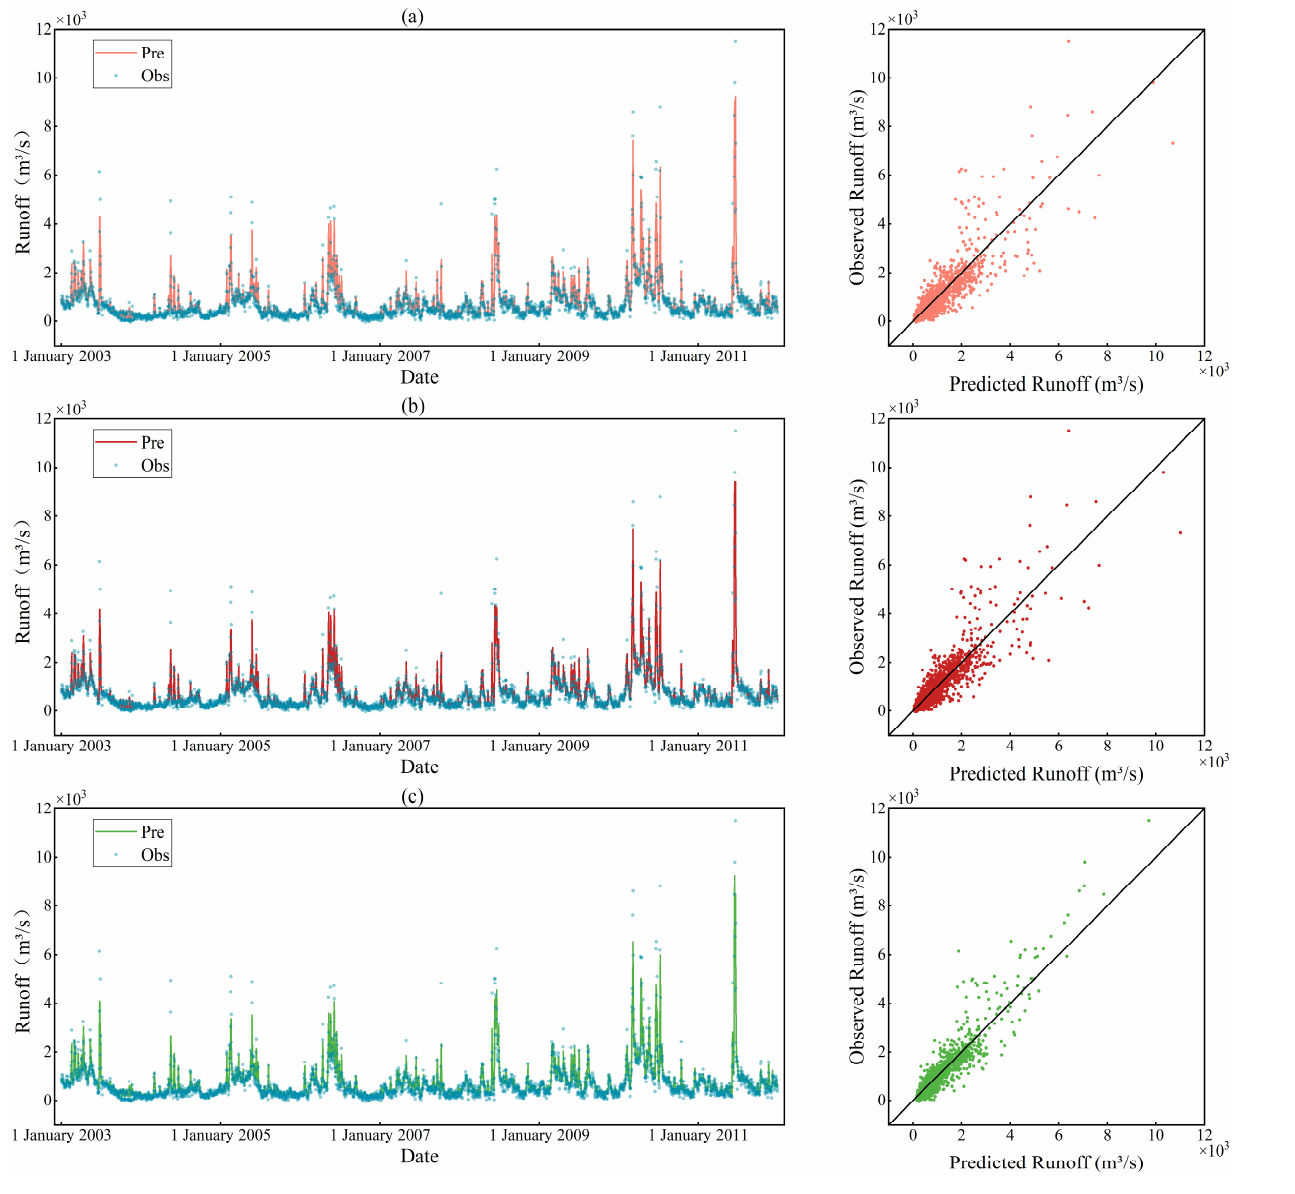
Figure 7. Runoff predicted by three base models against observations during the testing period: ( a ) RF, ( b ) AdaBoost, and ( c ) XGB. Table 3. Evaluation criteria of three stacking models (the values of RMSE and MAE are in m 3 /s).